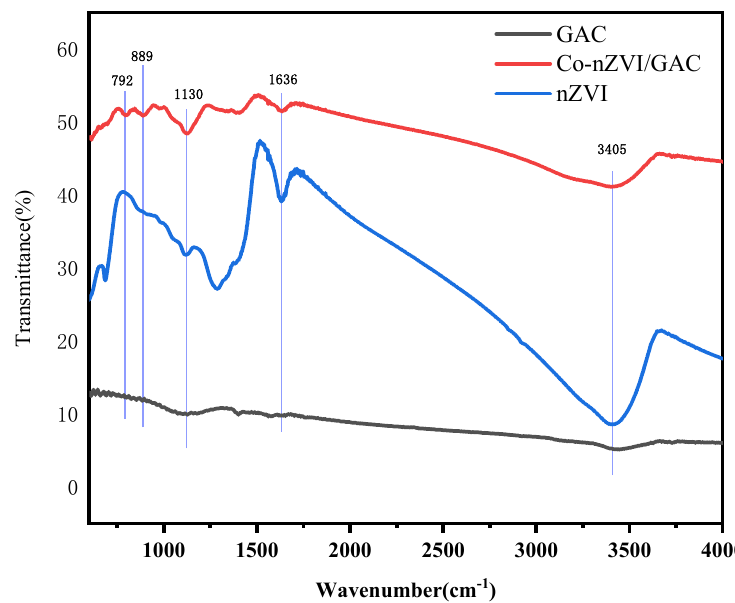
Figure 7. Infrared spectra of GAC, nZVI, and Co-nZVI/GAC.